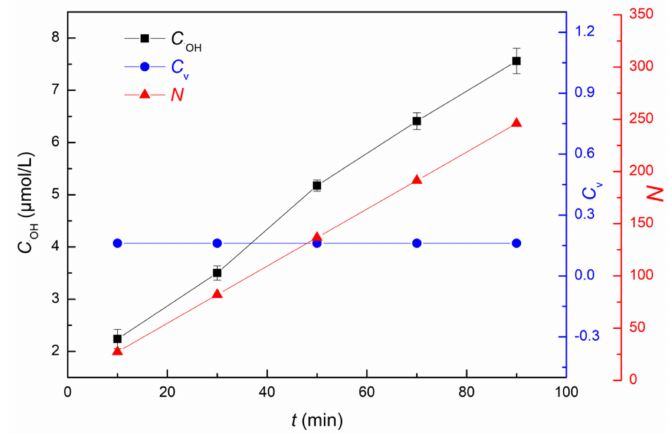
Figure 4. Influence of cavitation time on · OH yield, C v and N values. (Conditions: P i = 0.4 MPa, T = 30 ◦ C, d = 0.5 mm, V = 150